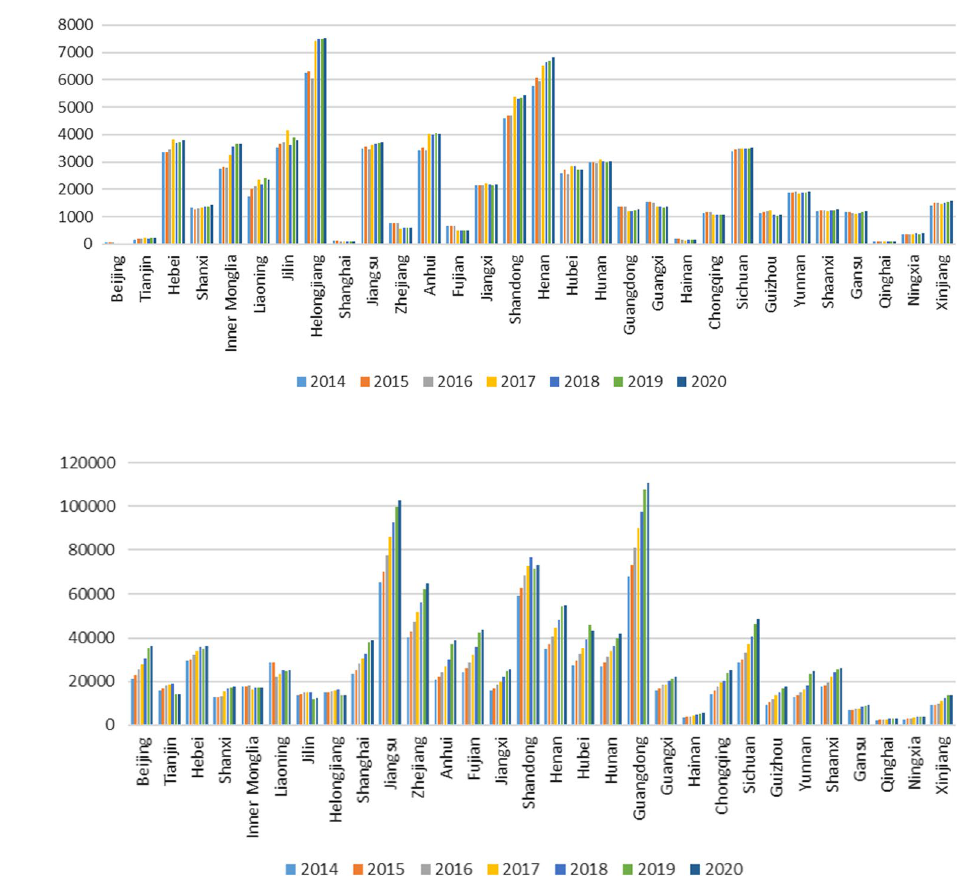
Fig. 4 2014–2020 food produc- tion in different regions of China